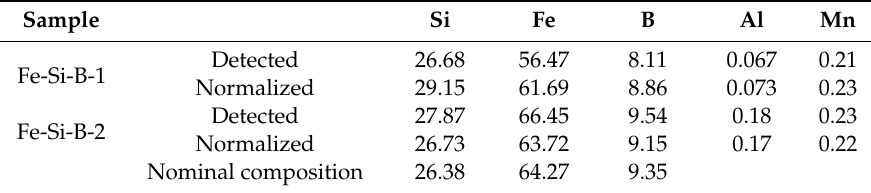
Table 4. Chemical composition of the master alloy analyzed by ICP-MS (mass %).